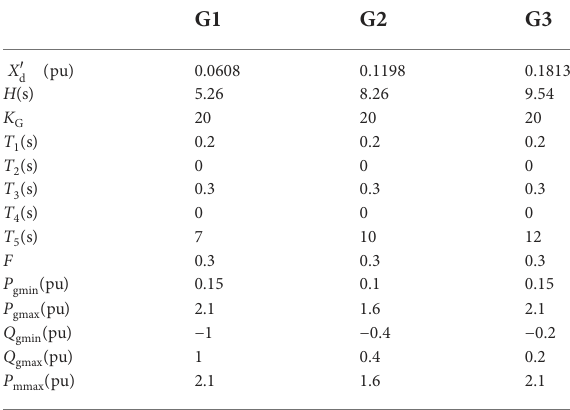
TABLE 1 Parameters of generators and turbine governors for WSCC 9-bus system.